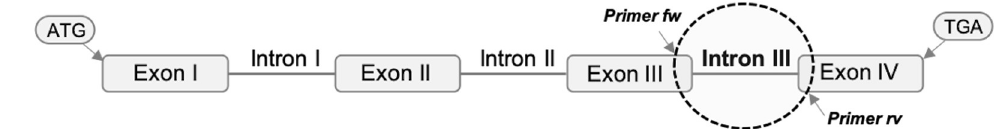
Fig 1. aTBP: An intron length polymorphism—Based method. The genomic organization of a generic vertebrate β - tubulin gene is shown. Intron III is used as the source of DNA polymorphism in a PCR reaction that is triggered by the use of the aTBP primer